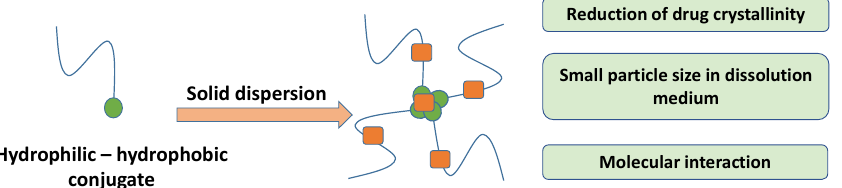
Figure 5. Illustration of the use of a hydrophilic–hydrophobic conjugate as a carrier in solid dispersion [59]. The drug molecules (orange dots) are dispersed between hydrophilic parts (blue strings) and hydrophobic parts (green dots).